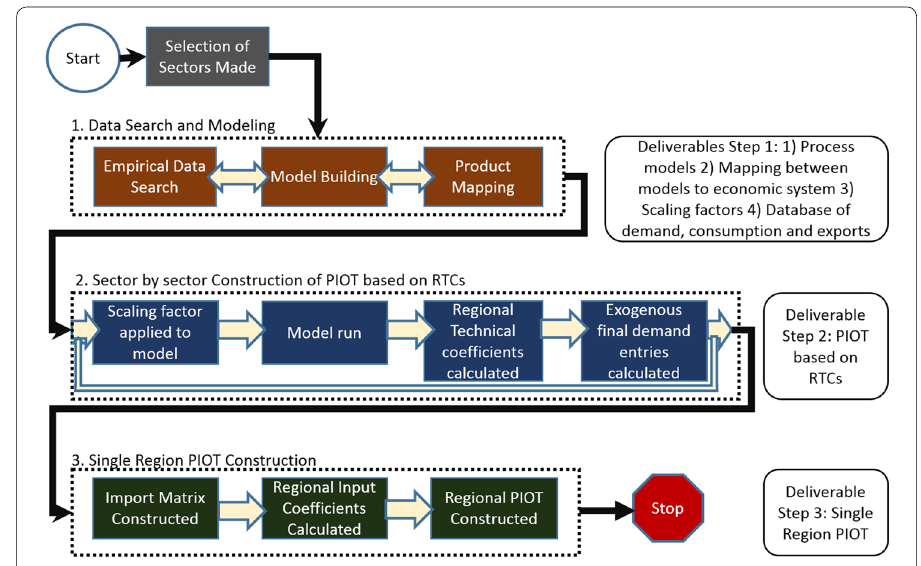
Fig. 1 Overview of the approach and methodology for building regional PIOTs from process models and empirical data. Step 1 is described in depth in Sect. 2.1.1, step 2 in Sect. 2.1.2 and step 3 in Sect.